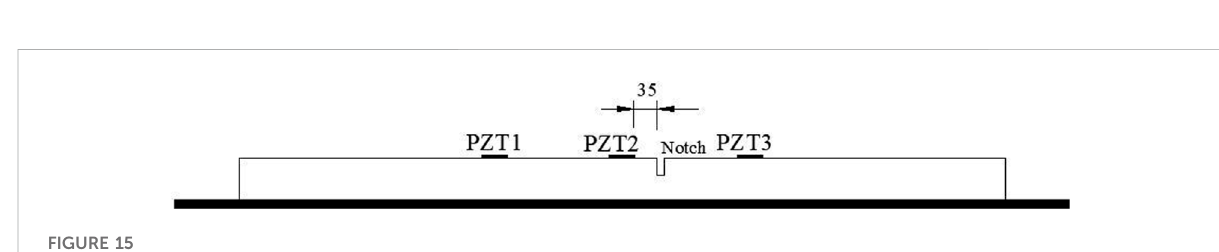
FIGURE 15 Damage scenarios of the steel-ECC composite